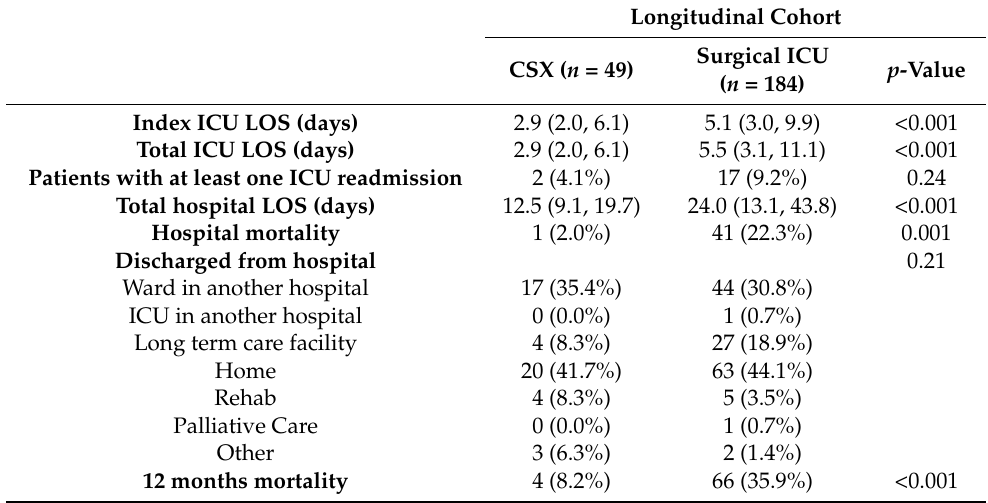
Table 2. Clinical outcomes in longitudinal and hospital groups, presented as median (Q1–Q3) or number and count (%). Abbreviations: LOS = Length of stay, ICU = Intensive Care Unit. Longitudinal Cohort CSX ( n =